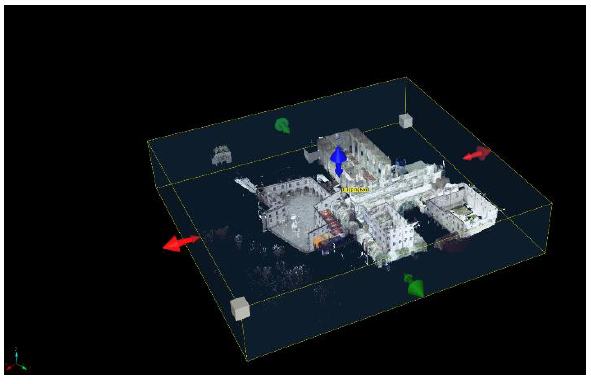
Figure 2. Clippingbox for section extrapolation (Faro Scene